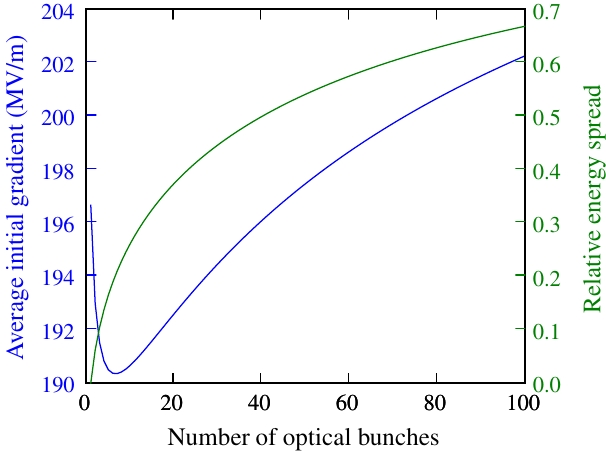
FIG. 5. The optimum reflectivity and the corresponding maxi- mum efficiency as a function of the number of optical micro- bunches in the bunch train.